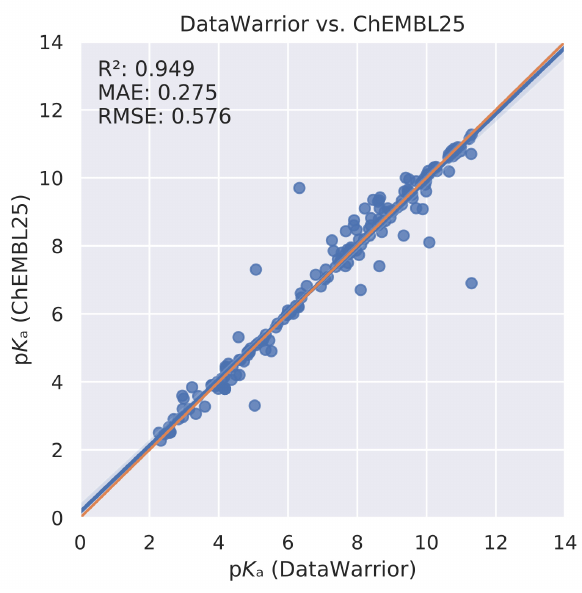
Figure 4. Intersection between ChEMBL and DataWarrior data sets. MAE, mean absolute error; RMSE, root mean square